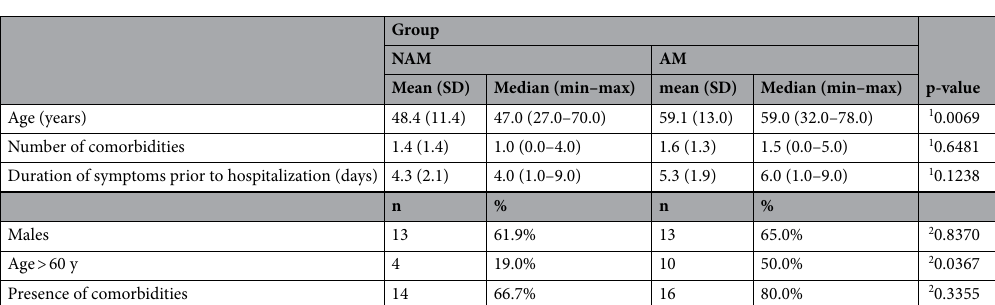
Table 1. Demographic and clinical data of both groups of patients: active mouthwash (AM) and non-active mouthwash (NAM) groups. 1 Mann Whitney-U; 2 Chi-square; SD standard deviation.